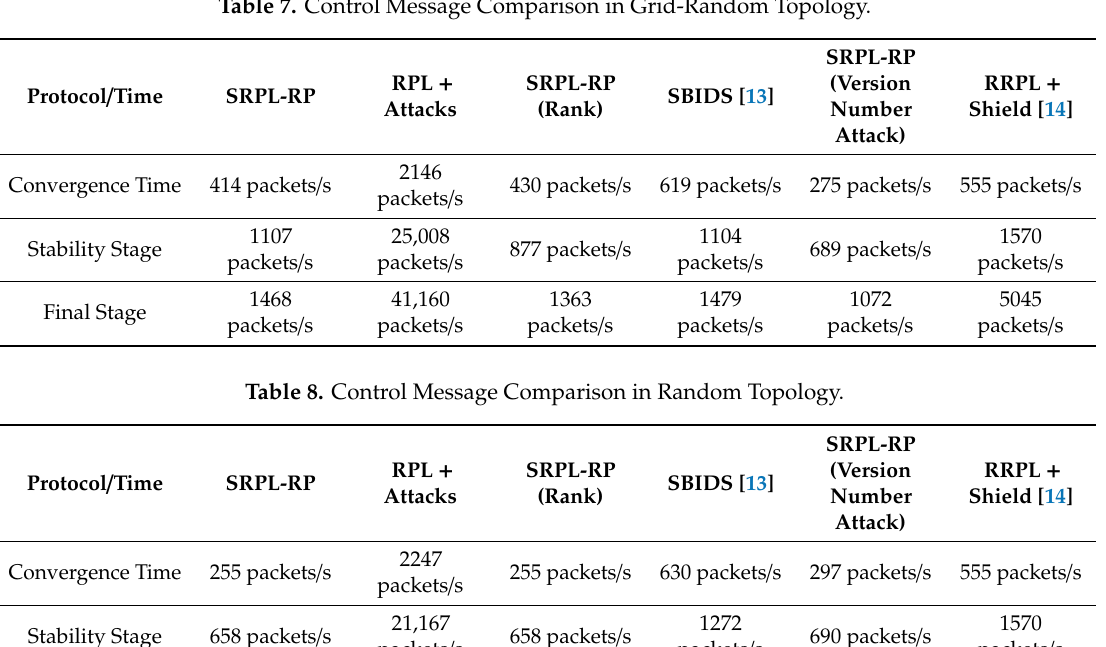
Table 7. Control Message Comparison in Grid-Random Topology.